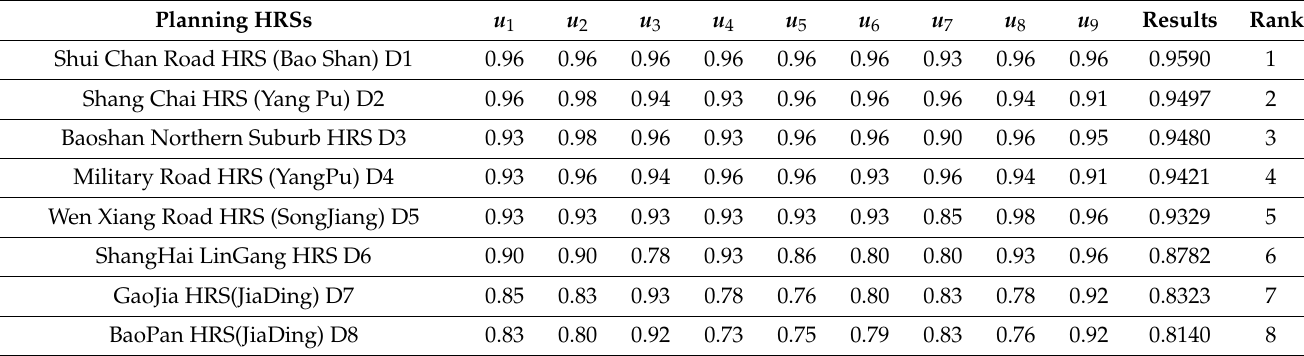
Table A2. Evaluation results of indices and ranking of planning HRSs in